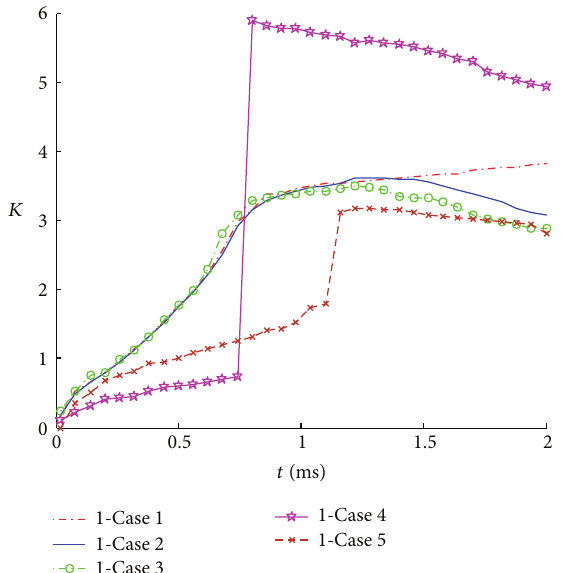
Figure 18: The crevasse variation of outer shell without interlayer water; cases are shown in Table 10.